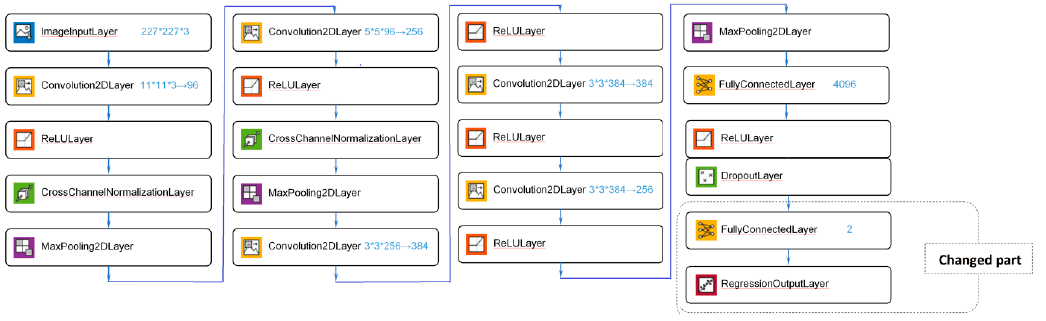
Figure 5. Transformed AlexNet in Matlab.